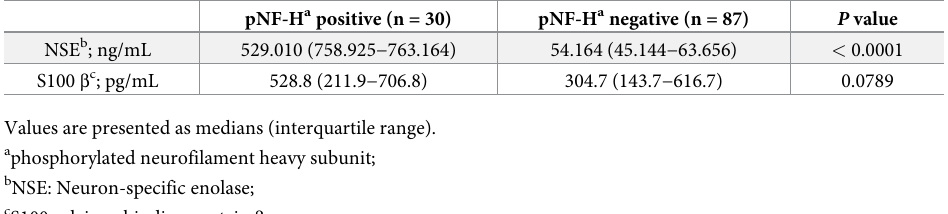
Table 3. Association between detection of phosphorylated neurofilament heavy subunit and candidate biomarker